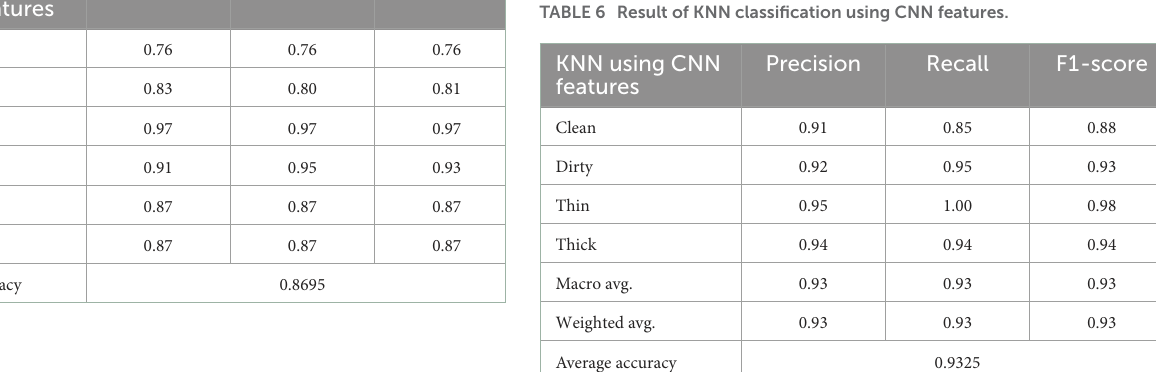
TABLE 6 Result of KNN classification using CNN